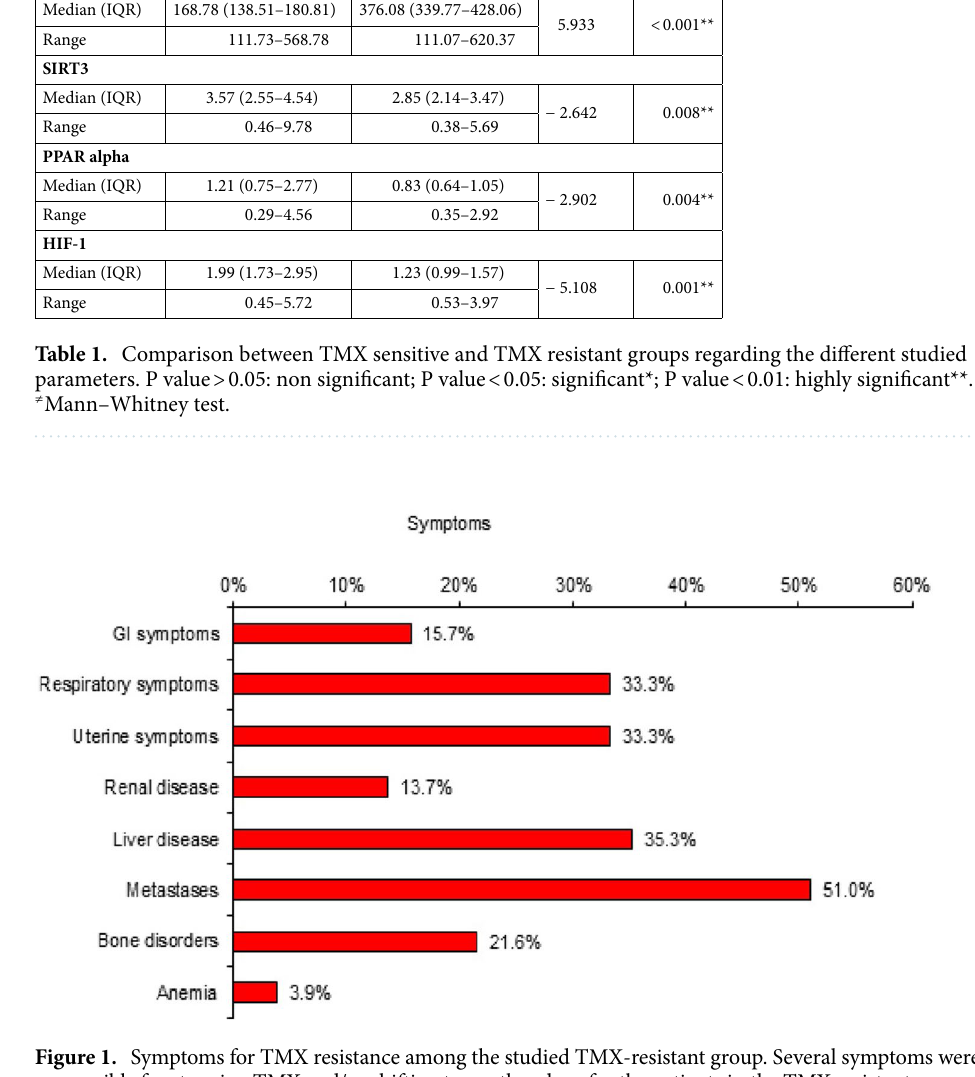
Figure 1. Symptoms for TMX resistance among the studied TMX‑resistant group. Several symptoms were responsible for stopping TMX and/or shifting to another drug for the patients in the TMX resistant group. The red bars in this figure shows 8 of the most dominant symptoms. Metastases was the most predominant symptom (51%) followed by liver disease (35.3%) and respiratory symptoms